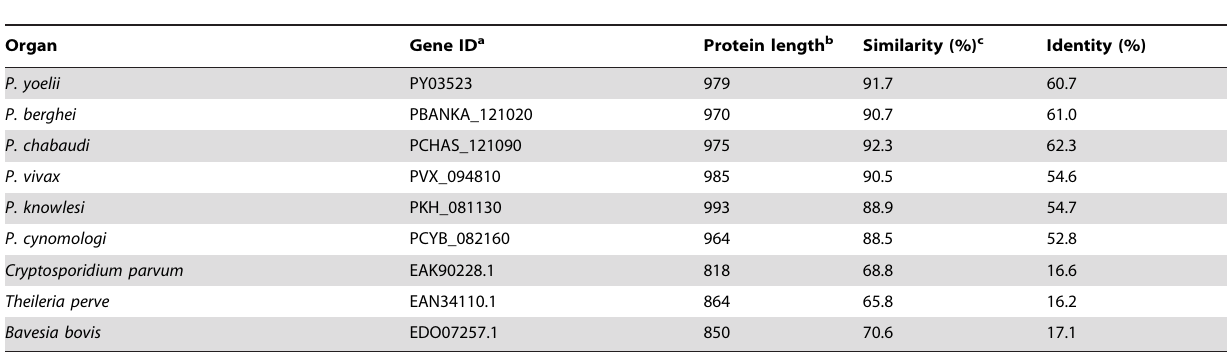
Table 1. The orthologs of PREBP in other Plasmodium and Apicomplexan